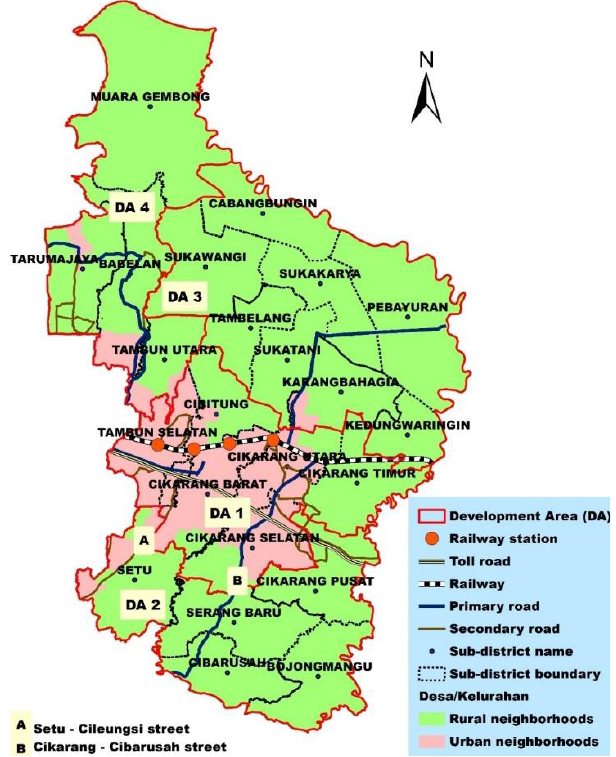
Figure 2. Delimitation of urban and rural neighborhoods of the Bekasi Regency in 2018. After the data were transformed and OLS analysis was performed, 7 out of 11 varia- bles met the best linear unbiased estimator (Table 4). The data from these seven variables were normally distributed, with no heteroscedasticity and no multicollinearity (tolerance value > 0.2 and VIF < 5 [60]) between the explanatory variables (Table 4). The seven vari- ables could significantly explain 66.3% of the determinants of the urban and rural neigh- borhoods in Bekasi Regency ( p < 0.05), and other factors outside the model explained the rest (Table 4). Table 4. OLS regression results summary. Variable